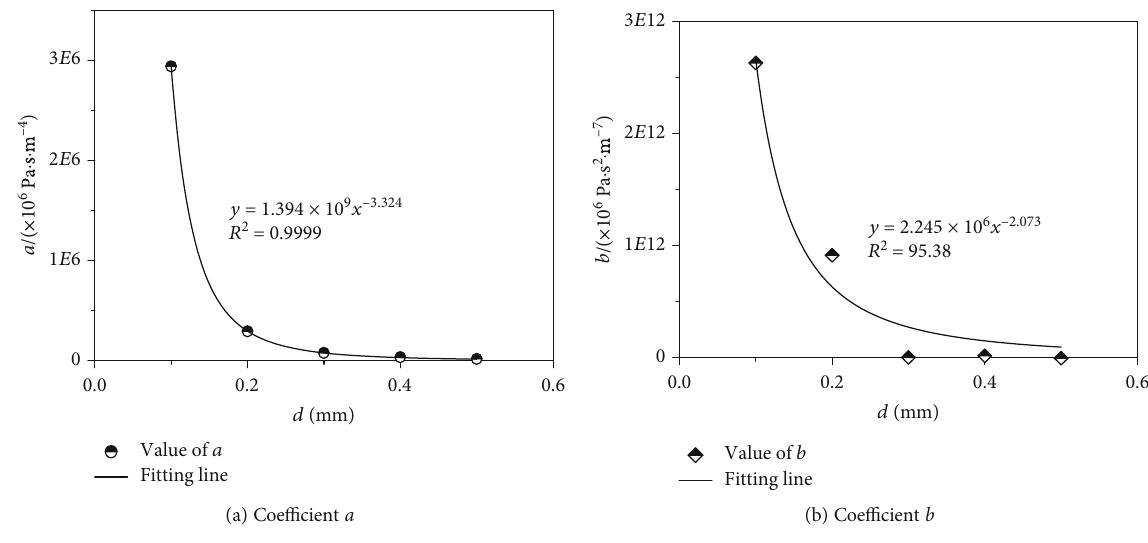
Figure 6: Variations in fi tting coe ffi cients in the Forchheimer law. Table 3: Fitting coe ffi cient in the Forchheimer